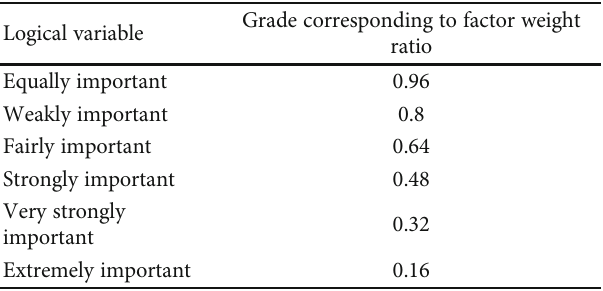
Table 5: The grading standard of the relative importance of the corresponding index to the